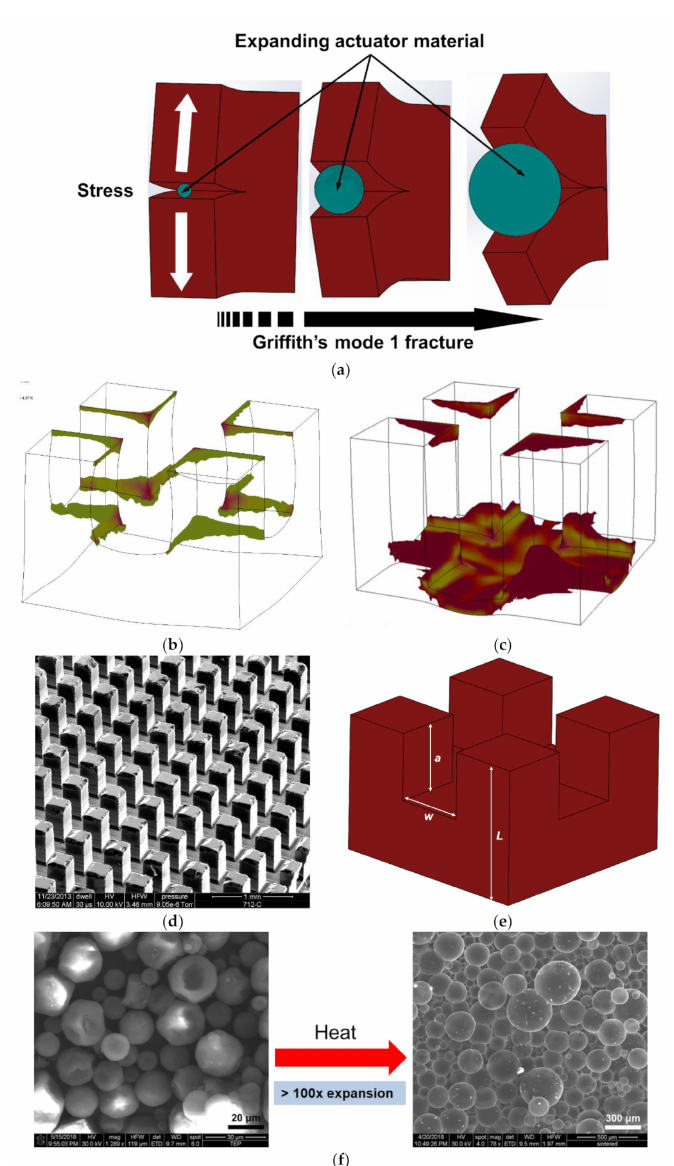
Figure 1. ( a ) Transience mechanism through Griffith’s mode 1 crack propagation. ( b , c ) COMSOL simulation results of a groove under stress. Simulated stress maps of a geometrically perfect crack in the form of partial grooves on the backside of a silicon wafer, showing regions of stresses higher than the yield strength of silicon on application of stress applied by expanding actuator material. Stress concentration on the edges and corners can be seen for ( b ) 250 µ m initial groove depth and ( c ) 450 µ m initial groove depth. Longer cracks have a larger area of high stress concentration which would result in more efficient transience, ( d ) 3D representation of the backside of a test chip with orthogonal grooved created by partial dicing, ( e ) the enlarged inset shows a typical crack site with characteristic dimensions where ‘a’ is the groove depth. ( f ) TE microsphere expansion under heat, resulting in >100 times increase in radius. The microspheres before expansion show thick walls compared to the expanded